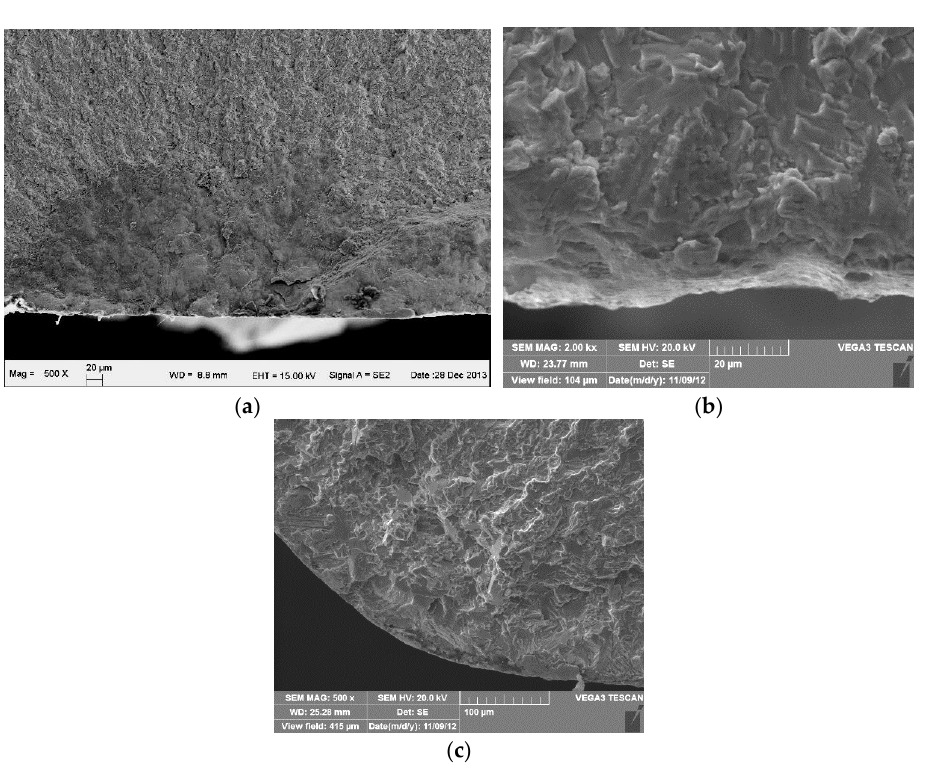
Figure 20. Cross-sectional micromorphology of FF specimen after failure with different modifications.